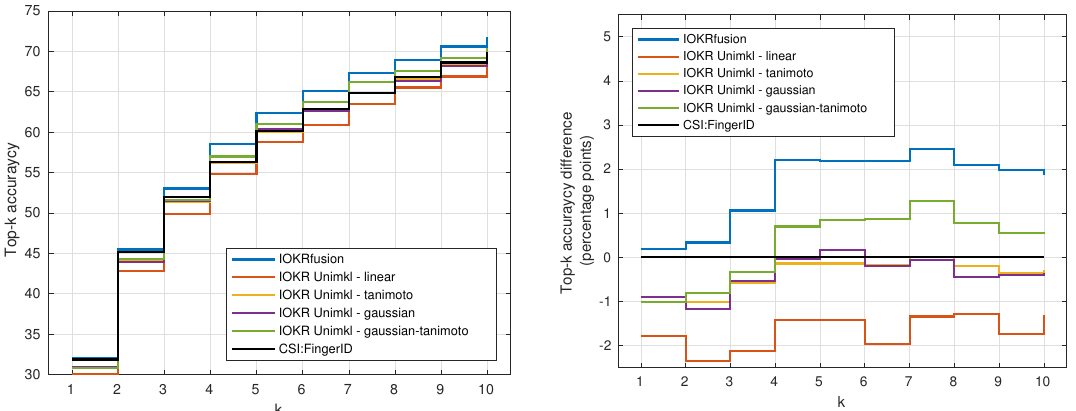
Figure 4. Plot of the top-k accuracy for IOKR Unimkl, CSI:FingerID and IOKRfusion in the negative ionization